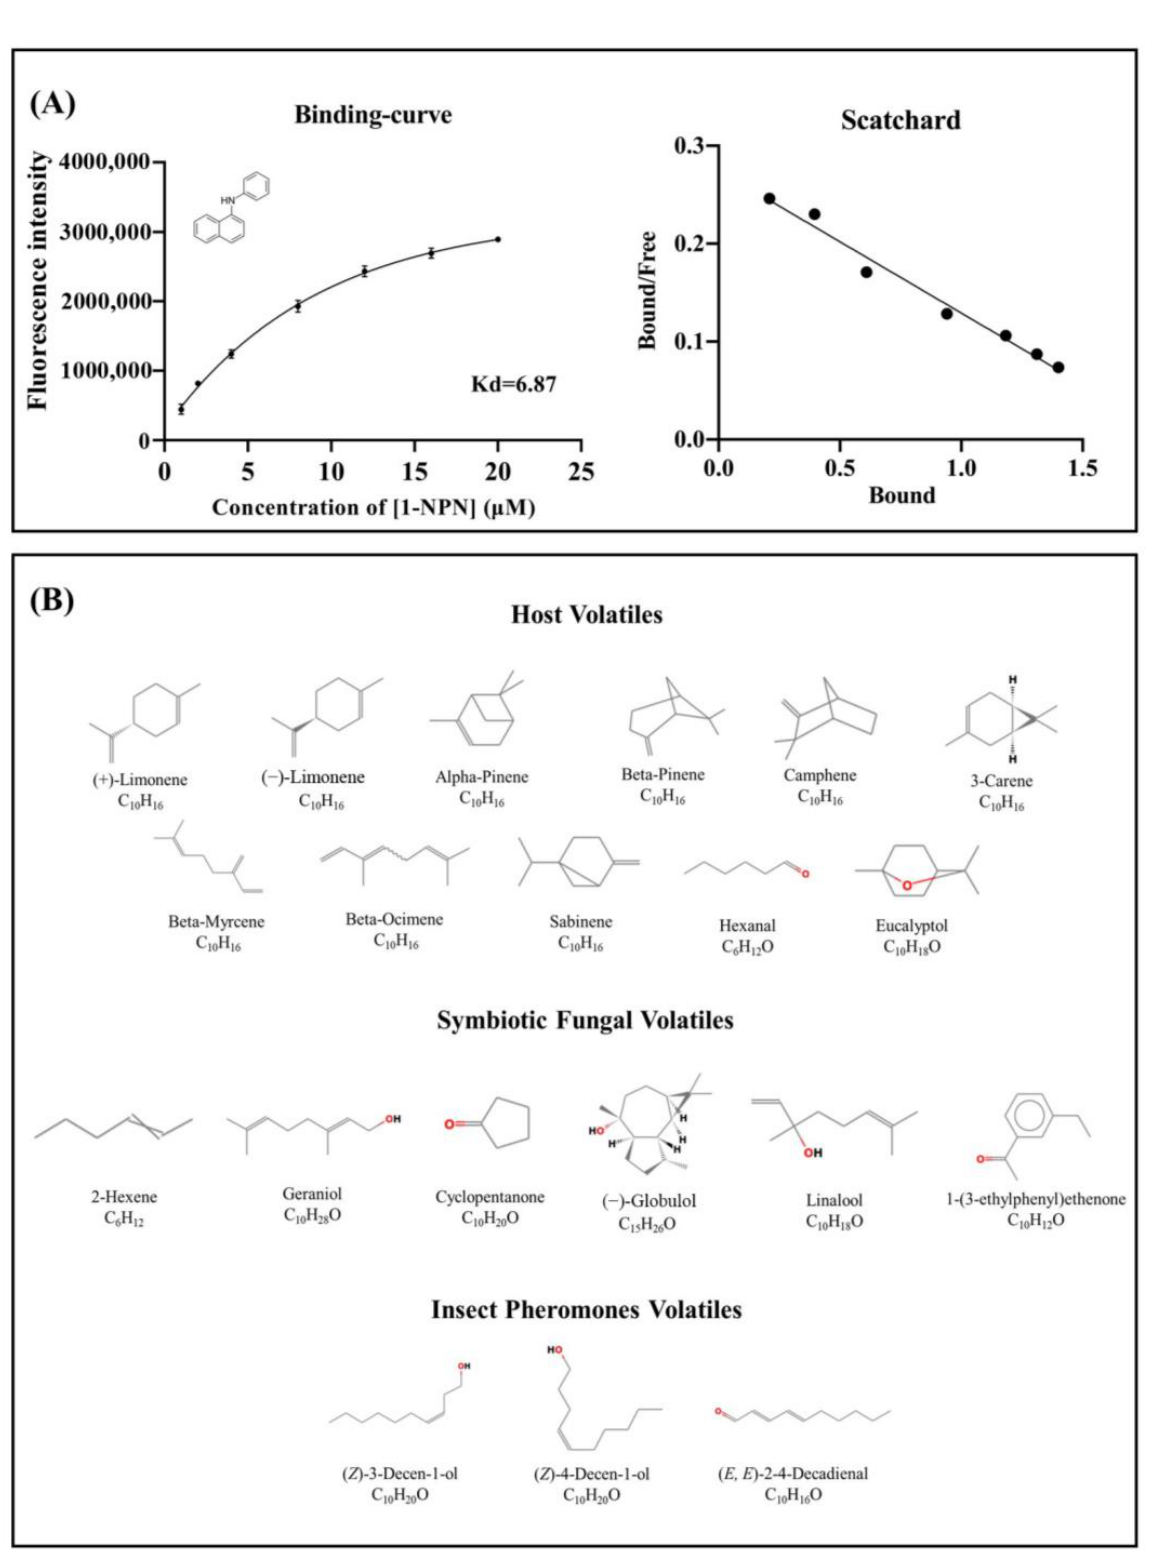
Figure 4. ( A ) Binding curve for 1-NPN to SnocOBP9 with Scatchard plot. Dissociation constant was Kd = 6.87 ± 0 .73 μM. ( B ) The chemical structure.